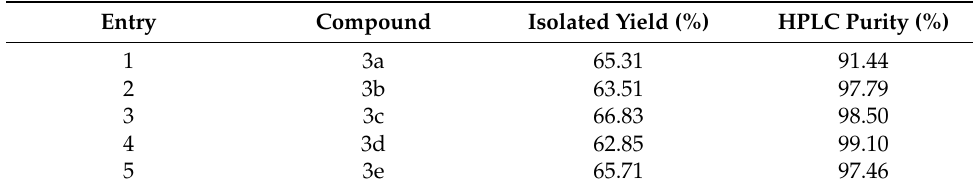
Table 1. Isolated yield and HPLC purity of synthesized coumarin-hydroxybenzohydrazide deriva- tives 3 .